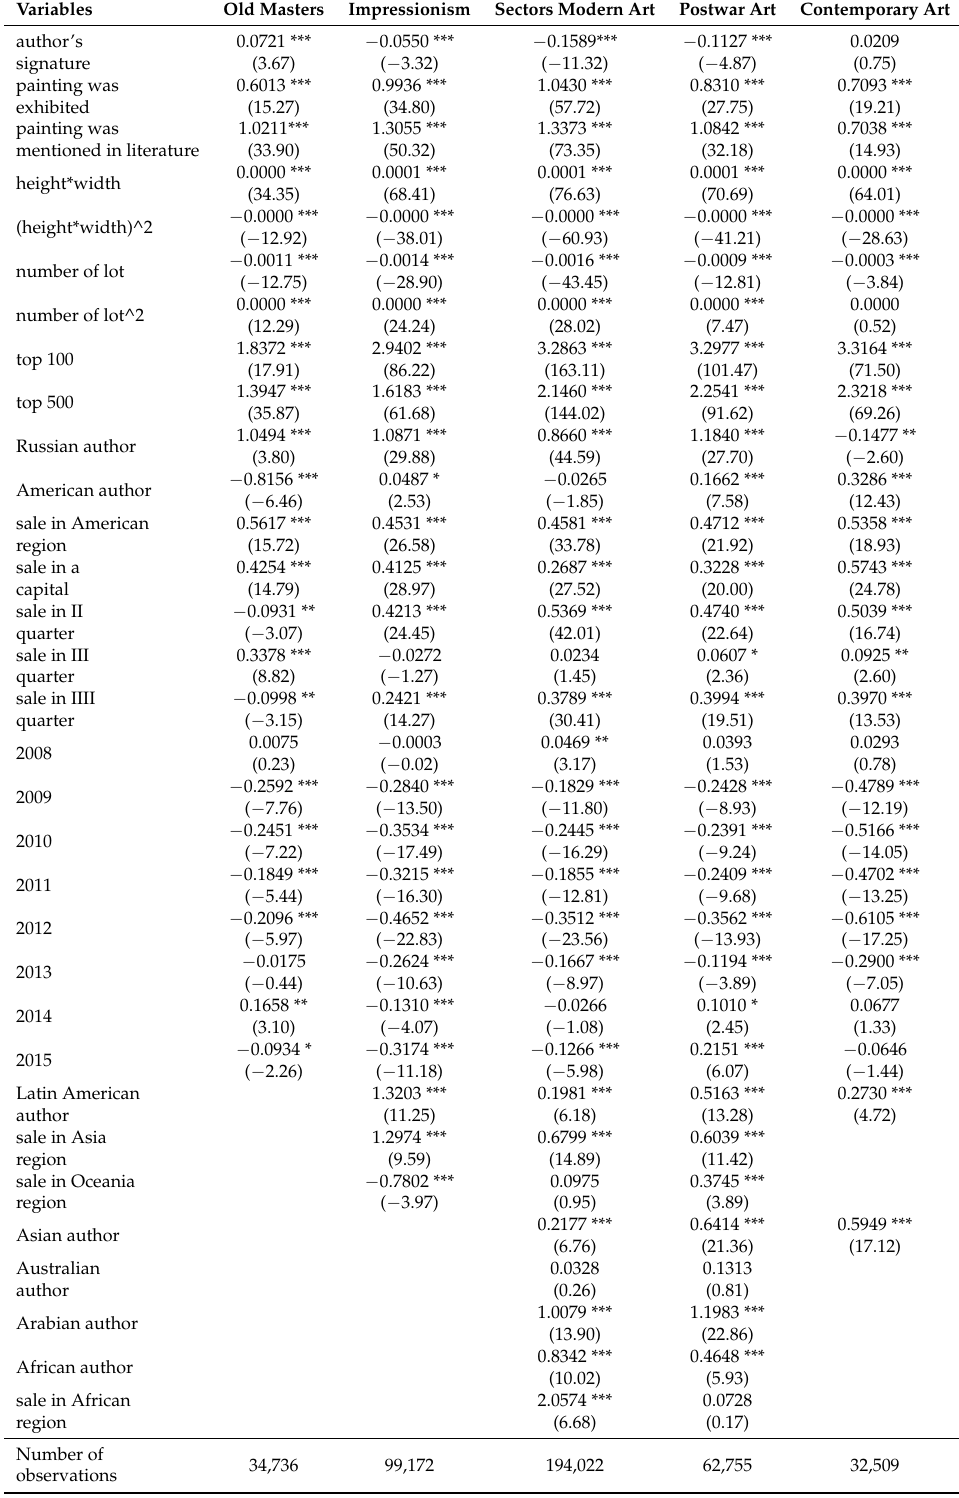
Table 1. The results for oil paintings hedonic art price index model, (1a). The dependent variable is the logarithm of the painting price. We estimate separate equations for each of five art sectors, namely Old masters, Impressionism, Modern art, Postwar art and Contemporary art. Coefficient t-statistics are